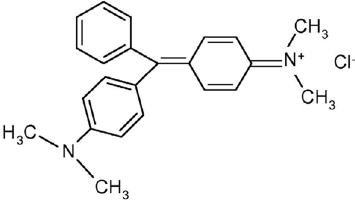
Fig. 1 Structural formula of MG